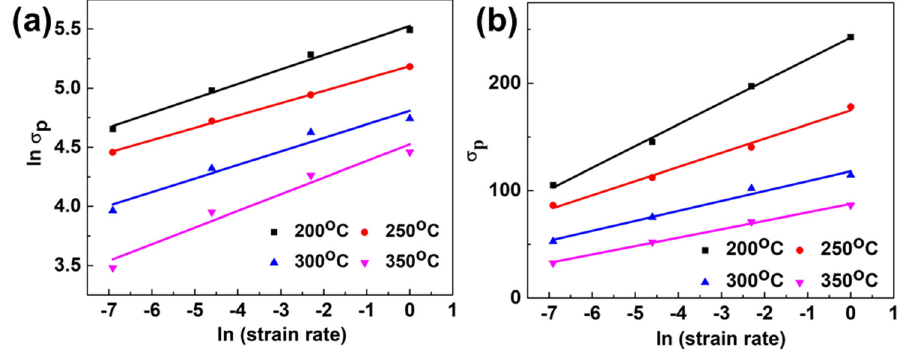
. − ln − ln (cid:0) . ε (cid:1) ( ε ) and ( b ) σ P P